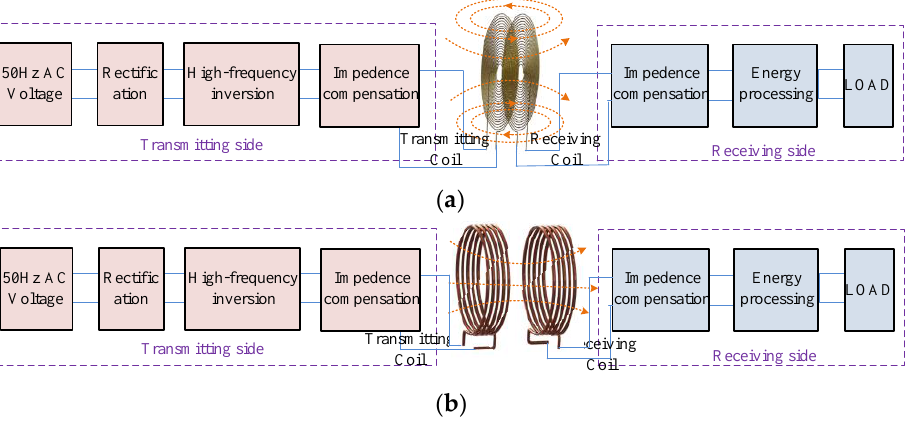
Figure 3. Basic composition of IWPT and MCR-WPT technologies: ( a ) Basic principle of IWPT technology; ( b ) Basic principle of MCR-WPT technology.